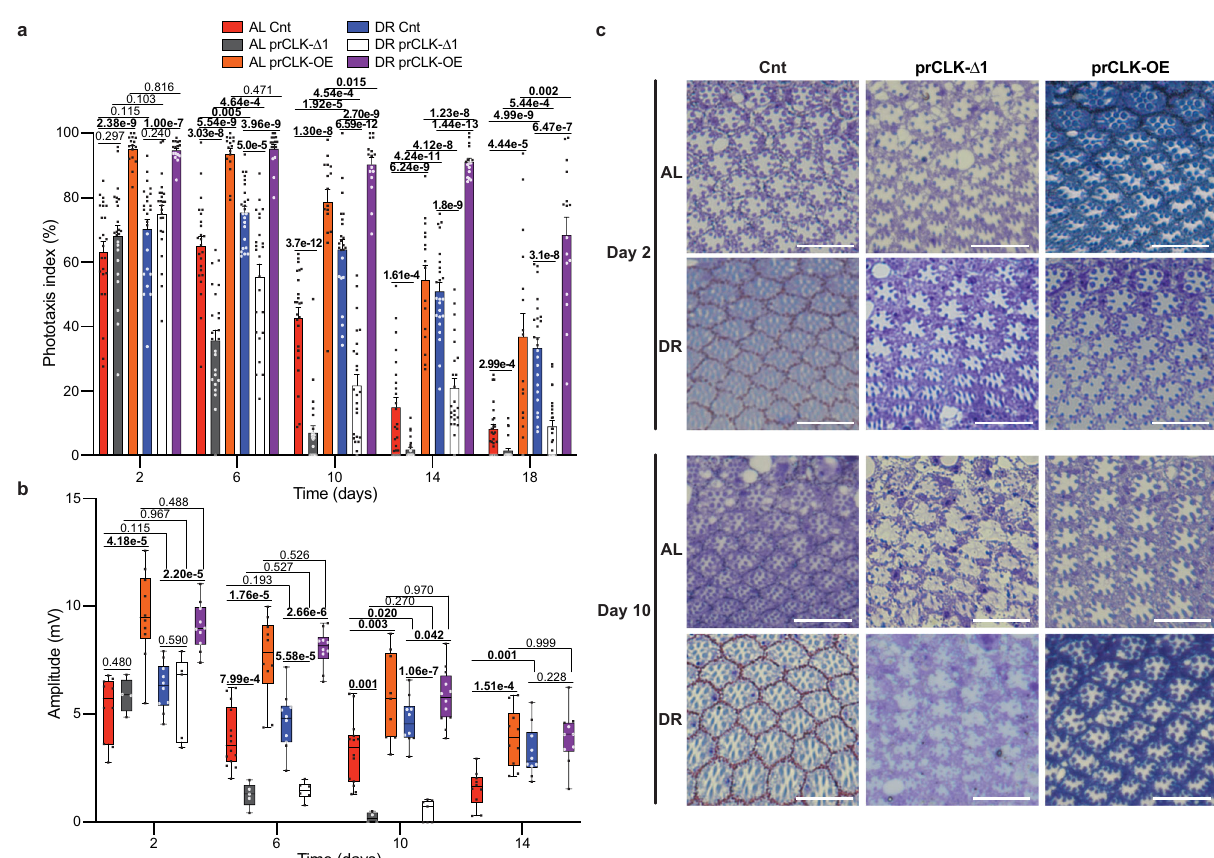
Fig. 3 Photoreceptor clocks modulate visual function and degeneration with age. a Positive phototaxis responses for prCLK- Δ 1 fl ies (Trpl-GAL4; GAL80 ts > UAS-CLK- Δ 1), prCLK-OE (Trpl-GAL4; GAL80 ts > UAS- Clk ), and control fl ies (Trpl-GAL4; GAL80 ts / + ) reared at 30 °C. For each timepoint results are represented as mean values of percent positive phototaxis ±SEM (control and prCLK- Δ 1: n = 24 biologically independent cohorts of 20 fl ies examined over three independent experiments, N = 480 fl ies per condition. prCLK-OE: n = 16 biologically independent cohorts of 20 fl ies examined over 2 independent experiments, N = 320 fl ies per condition). P- values were determined by two-tailed Student ’ s t -test (unpaired), comparing responses between diet and/or genotype at each timepoint. b Boxplots of electroretinogram amplitudes for prCLK- Δ 1, prCLK-OE, and control fl ies reared at 30 °C. The sample sizes ( n ) corresponding to ( b ) can be found in the “ Statistics and Reproducibility ” section within the Methods. Data are presented as Tukey multiple comparison of means: The horizontal line within each box is the median, the bottom and top of the box are lower and upper quartiles, and the whiskers are minimum and maximum values. P -values were determined by two-tailed Student ’ s t -test (unpaired), comparing responses between diet and/or genotype at each timepoint. c Tangential sections through prCLK- Δ 1, prCLK-OE, and control retinas at day 2 and day 10. R1-7 photoreceptors are apparent within each hexongonally shaped ommatidia. White bars in bottom right corners represents 10 microns. The number of biologically independent replicates for each group within this experiment are in the Statistics and Reproducibility section. Additional representative images are included with the source data fi